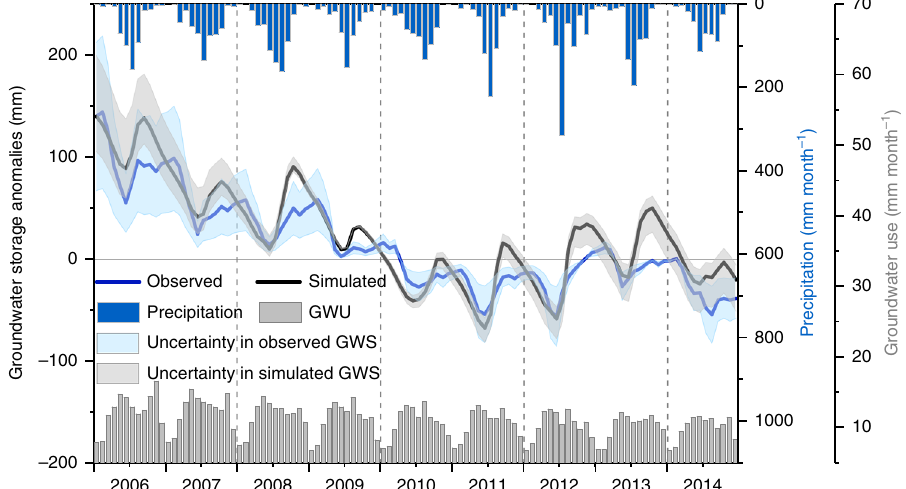
Fig. 4 GWS anomalies, precipitation, and GW use for 2006 ‒ 2014. Uncertainty in simulated monthly GWS was estimated based on varying aquifer thicknesses from 100 to 250 m derived from aquifer properties. Uncertainty in observed GWS was approximated by the standard deviation of speci fi c yield values (0.042) from 25 recorded wells across the Beijing Plain. The model calibration period spans from 2006 to 2010 and the validation period spans from 2010 to 2014. R 2 between the simulated (trend: 13.1 mm year − 1 ) and observed (trend: 14.4 mm year − 1 ) GWS changes for the validation period is